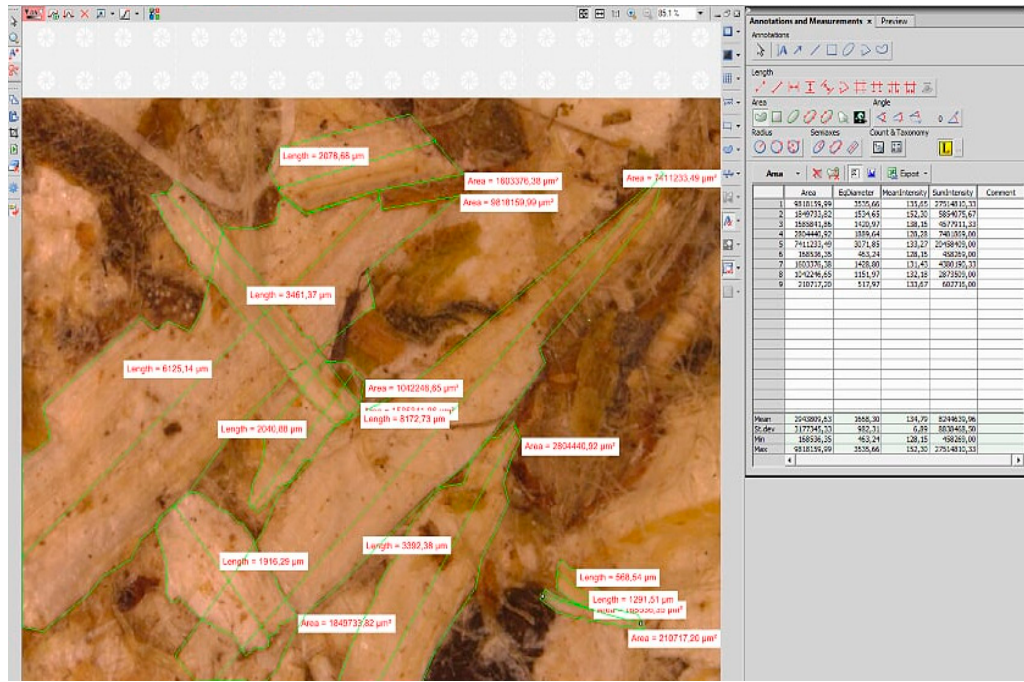
Figure 6. Size measurement of hemp briquette’s particles via NIS-Elements AR software (Version 2.3, Laboratory Imaging s.r.o. , Prague, Czech Republic).